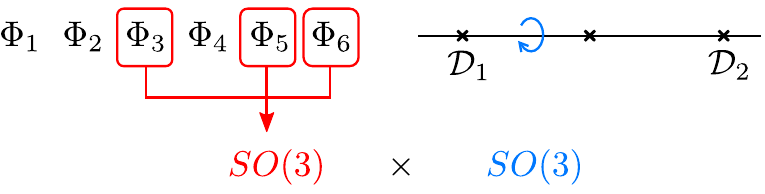
Figure 6 . The bosonic parts of the diagonal PSU(2 j 2)